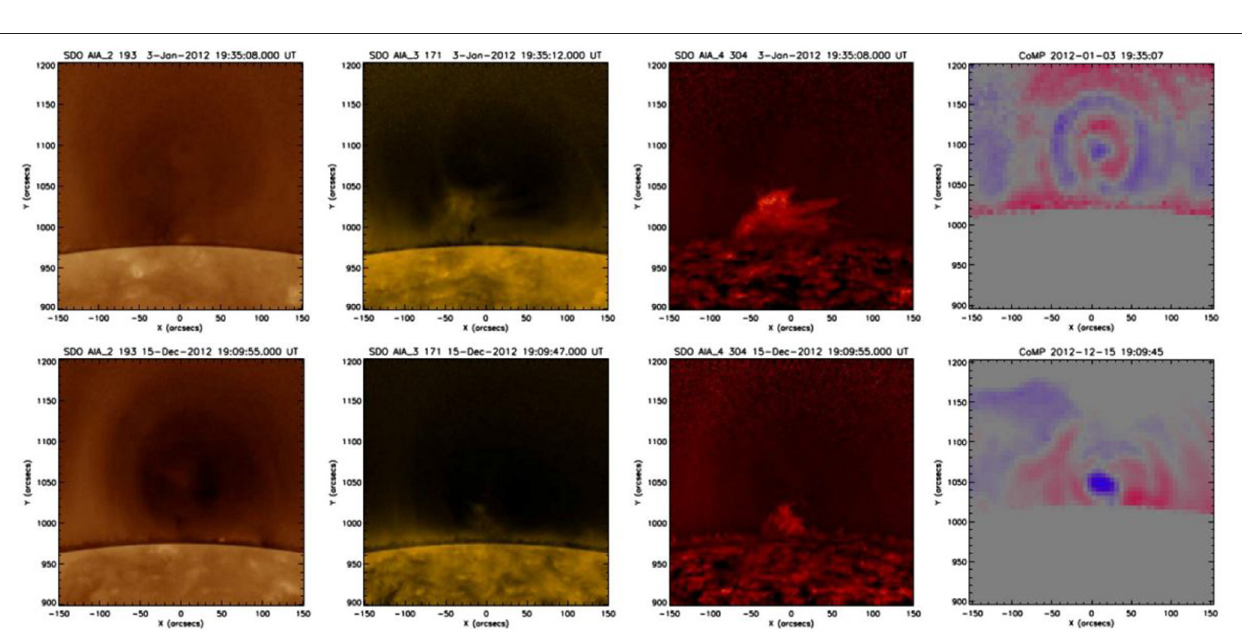
FIGURE 8 | Left: Histogram of difference between cavity center height and prominence top height, Right: Cavity center height vs. prominence top height. Correlation coefficient is equal to 0.59.